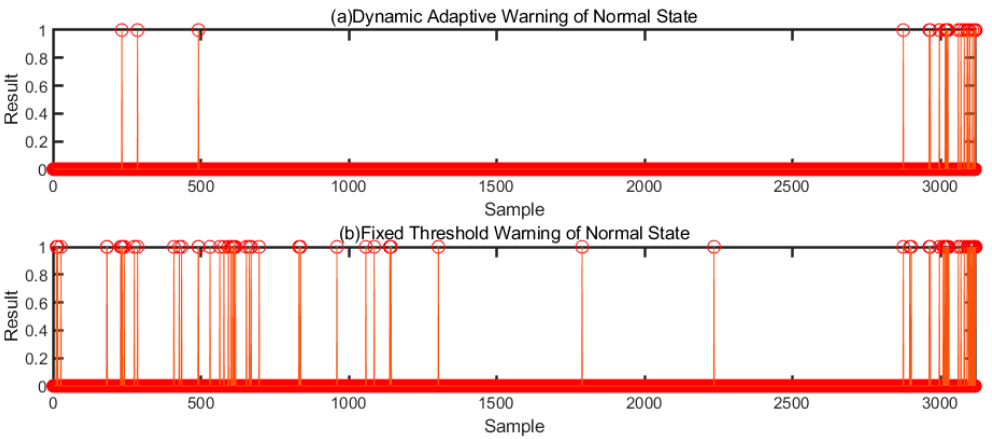
Figure 10. Warning results based on the different threshold methods.